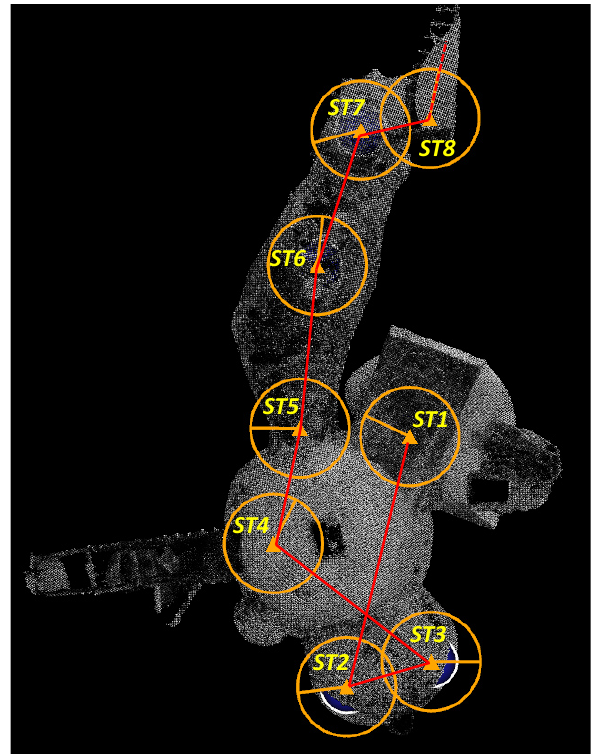
Figure 8. The scheme of scan points inside the “Sybil hypogeum”.